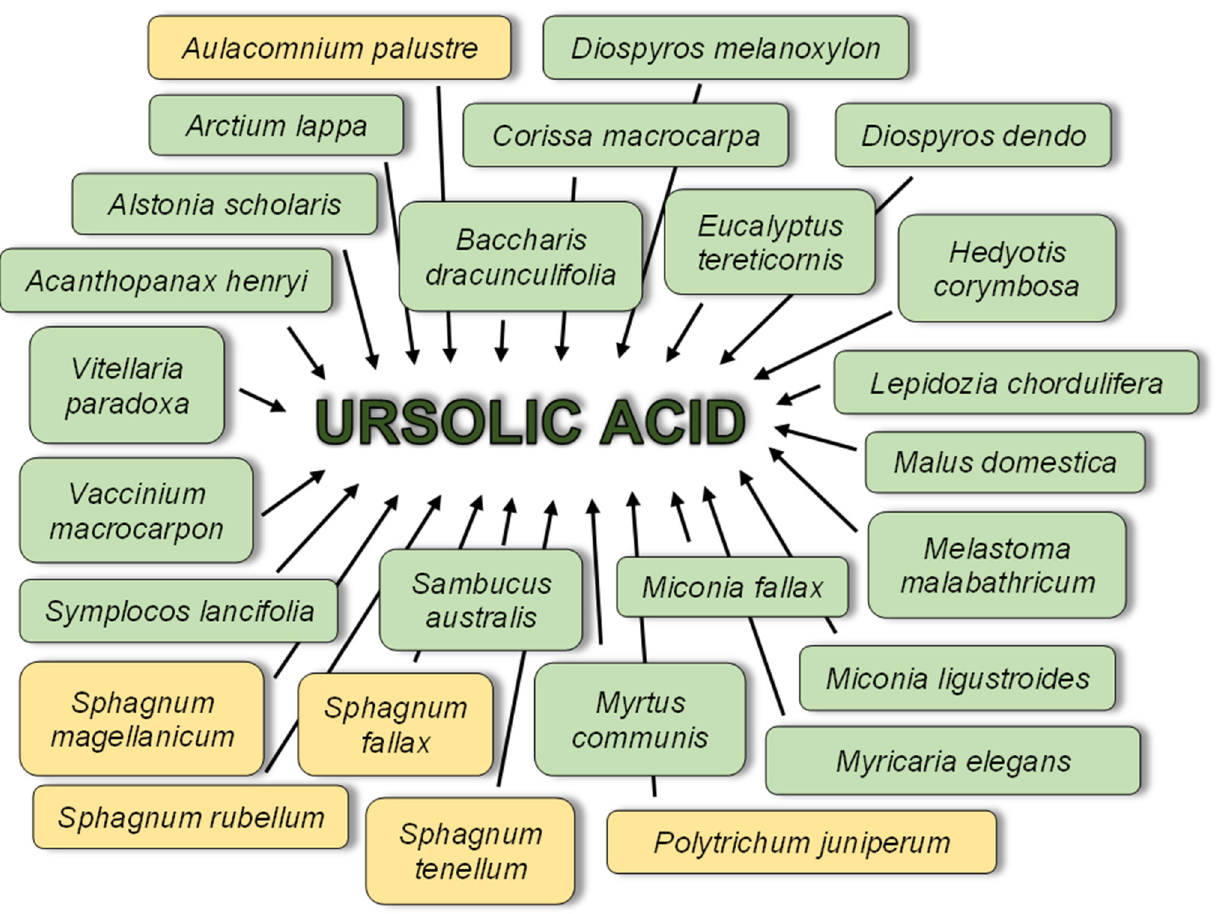
Figure 4. Plant sources of ursolic acid used in antibacterial experiments; green boxes—angiosperms; yellow boxes—bryophytes.